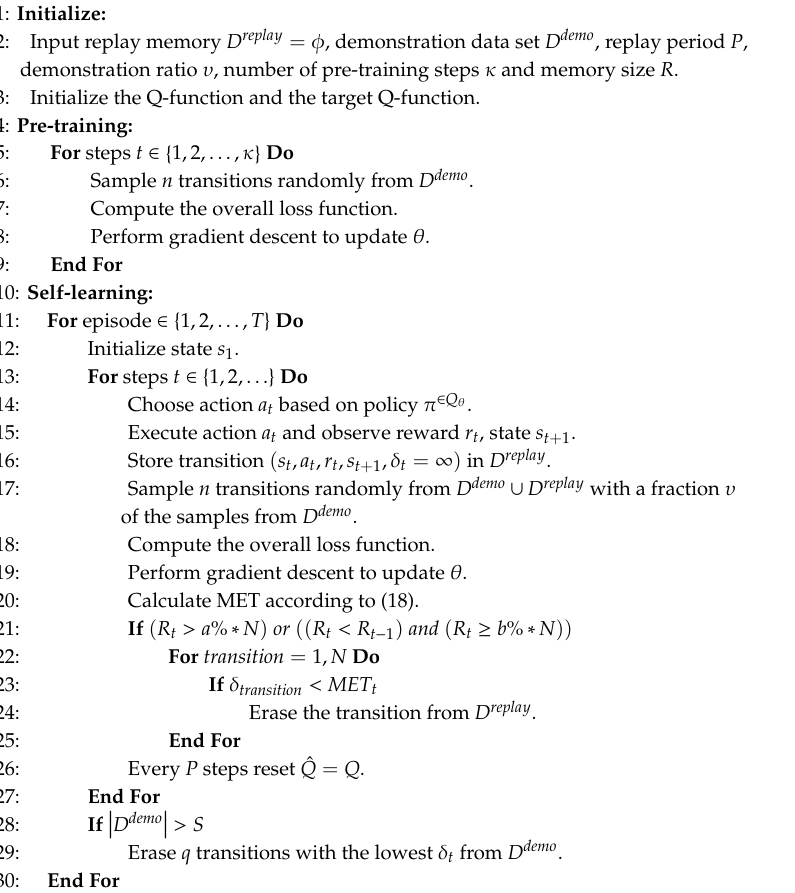
Algorithm 1 Prioritized Memories Deep Q-learning from Demonstrations